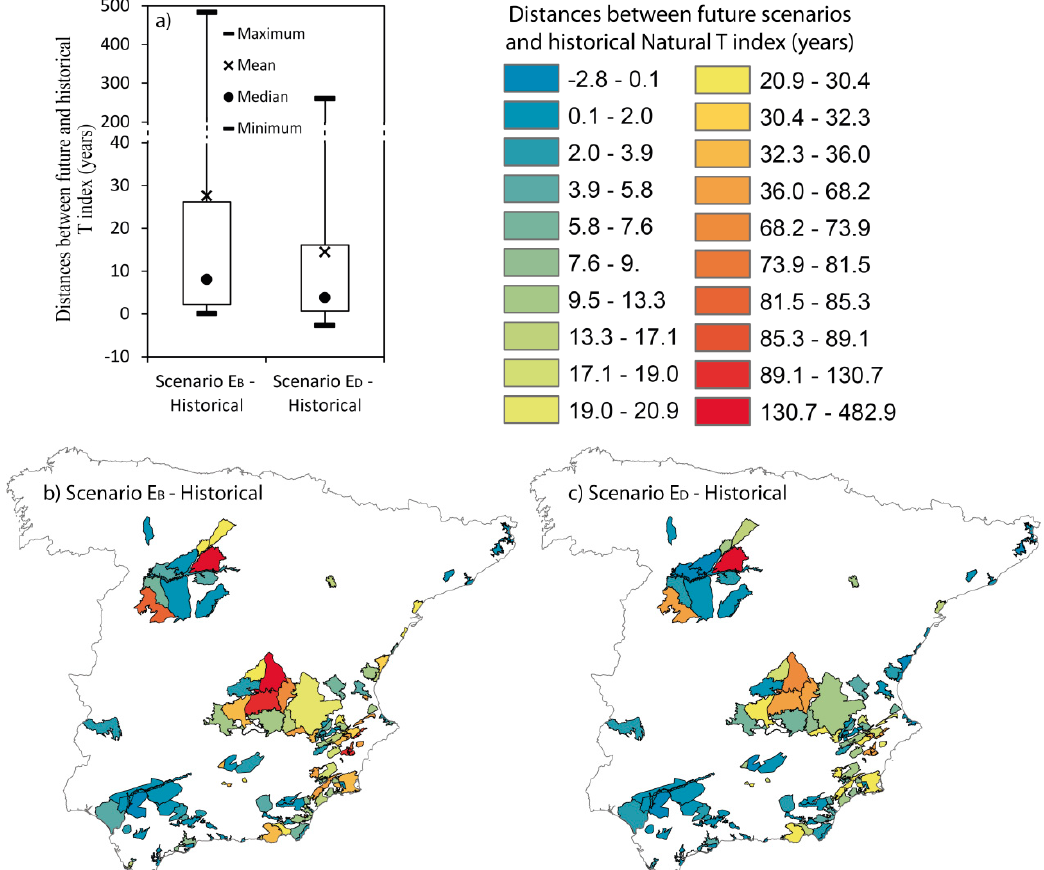
Figure 8. Box-Whiskers ( a ) and maps ( b , c ) of the distances between historical natural T and future potential values in horizon 2011–2045.